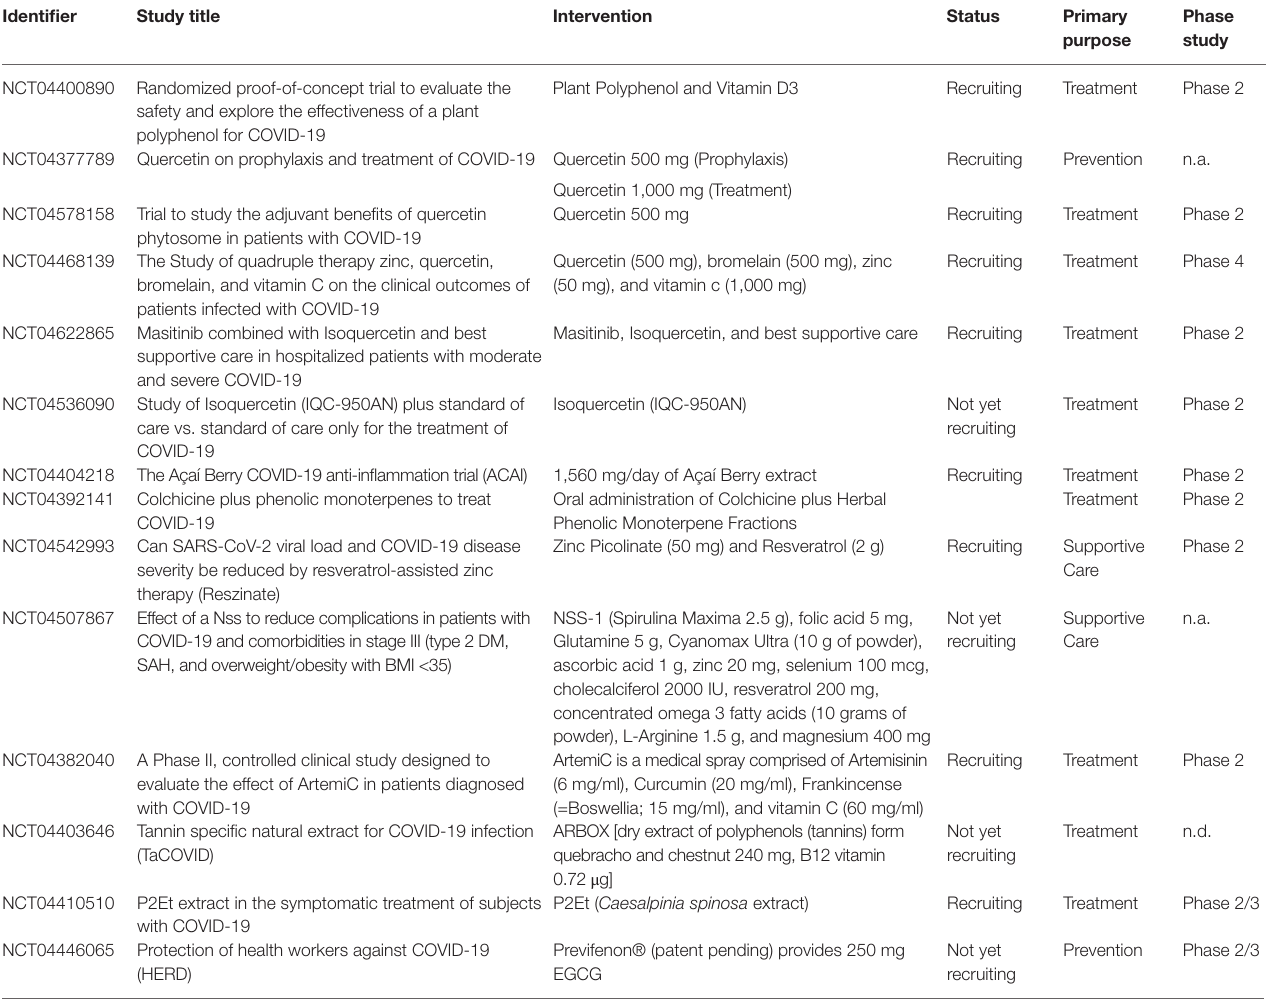
TABLE 1 | Clinical trials evaluating polyphenols in coronavirus disease 2019 (COVID-19)